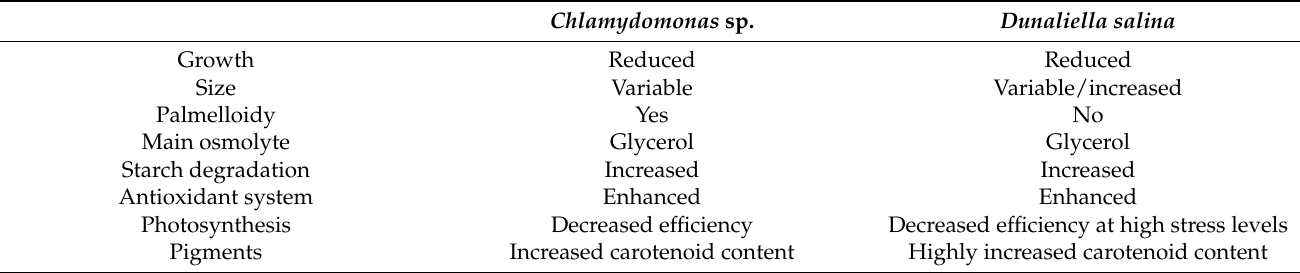
Table 1. This table summarizes the main characteristics of salt tolerance found in the Chlamydomonas genus, compared with the other model green microalga Dunaliella salina [49,52–55]. Chlamydomonas